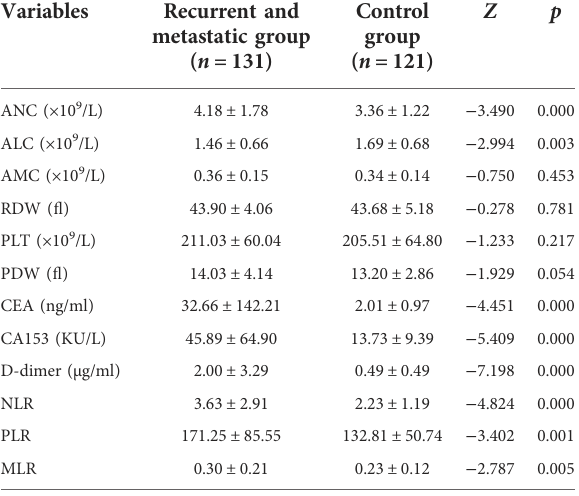
TABLE 3 Comparison of hematological parameters in the two groups.